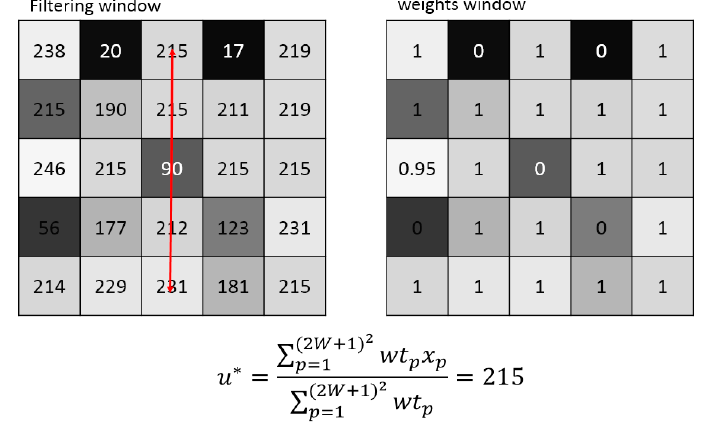
Figure 7. Repair of brighter areas ( u * = 215).